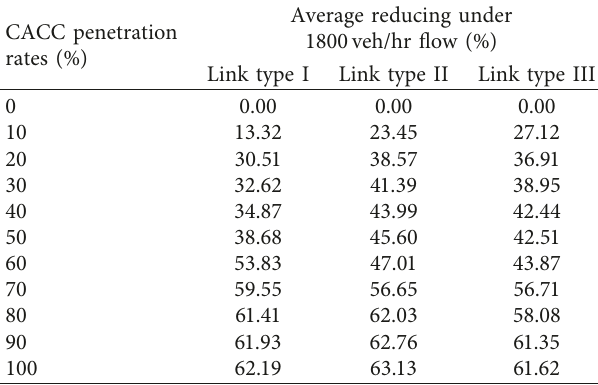
Table 1: Percentage reductions of CI under 1800veh/hr flow. CACC penetration